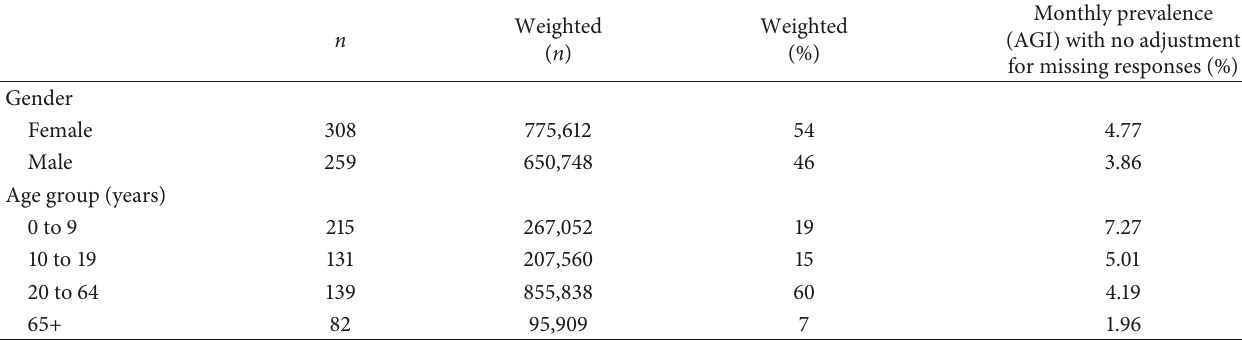
Table 7: Age and gender breakdown for cases of AGI ( n (cid:136) 567) without adjustment for 225 missing responses and corresponding monthly prevalence of AGI based on weighted